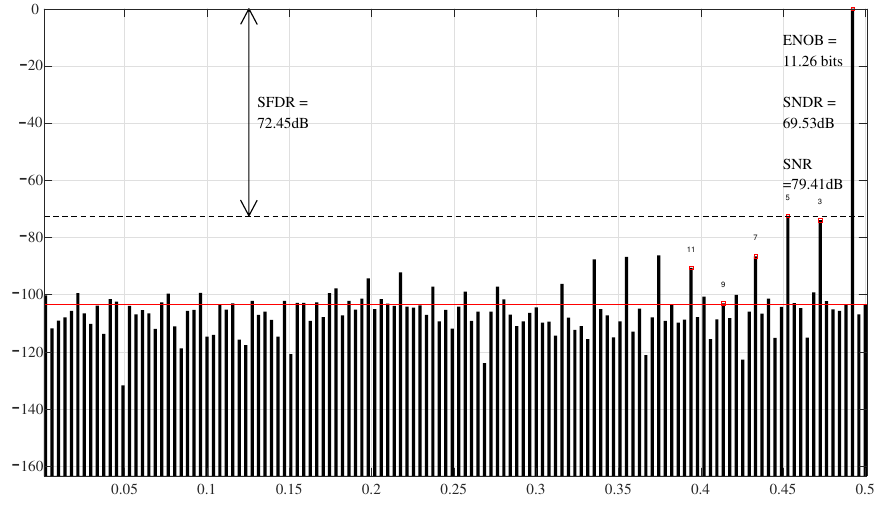
Figure 11. Simulated FFT spectrum at 32 MS/s with 15.7 MHz input of the bootstrapped